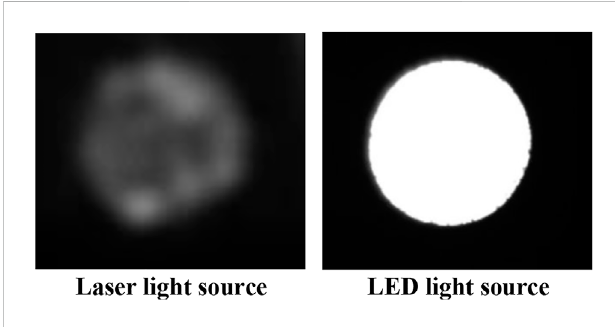
FIGURE 12 Comparison of imaging effects of different light sources.